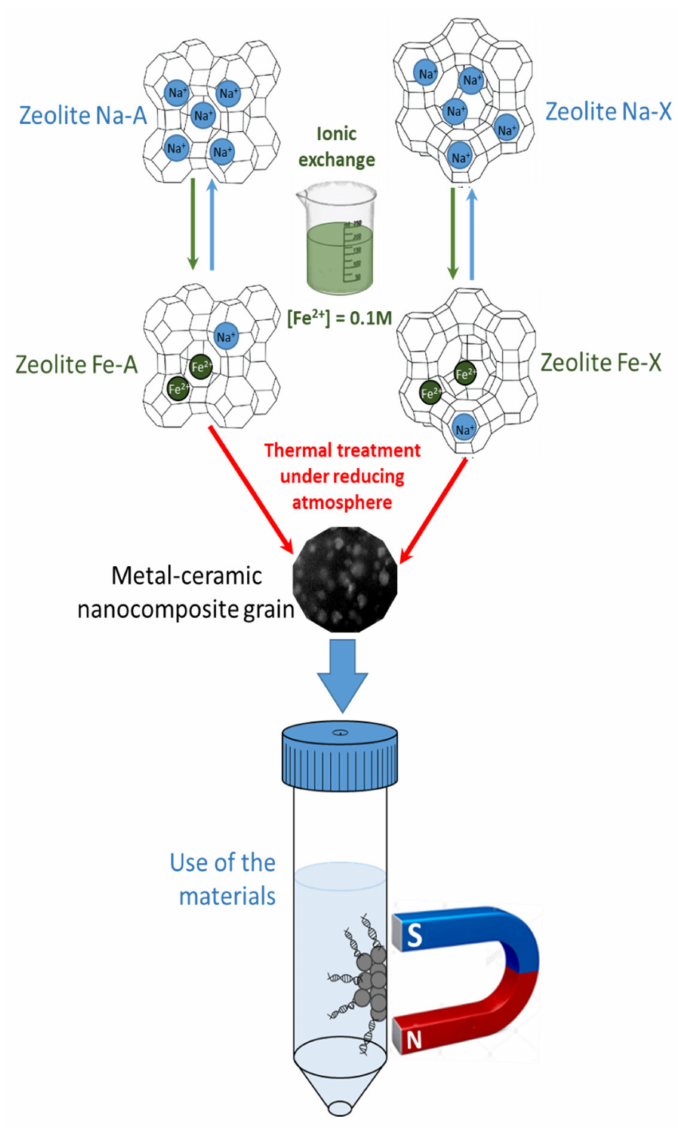
Scheme 1. Scheme (not in scale) of the preparation procedure of the magnetic adsorbents by Fe 2